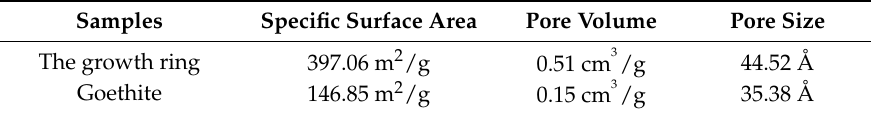
Table 2. Specific surface area, pore volume and pore size of the growth ring and goethite.